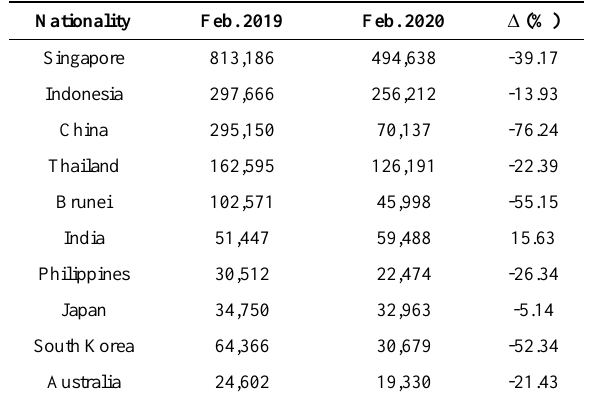
Table 3. Changes of International Tourist Arrivals in Feb. 2019 versus Feb. 2020.